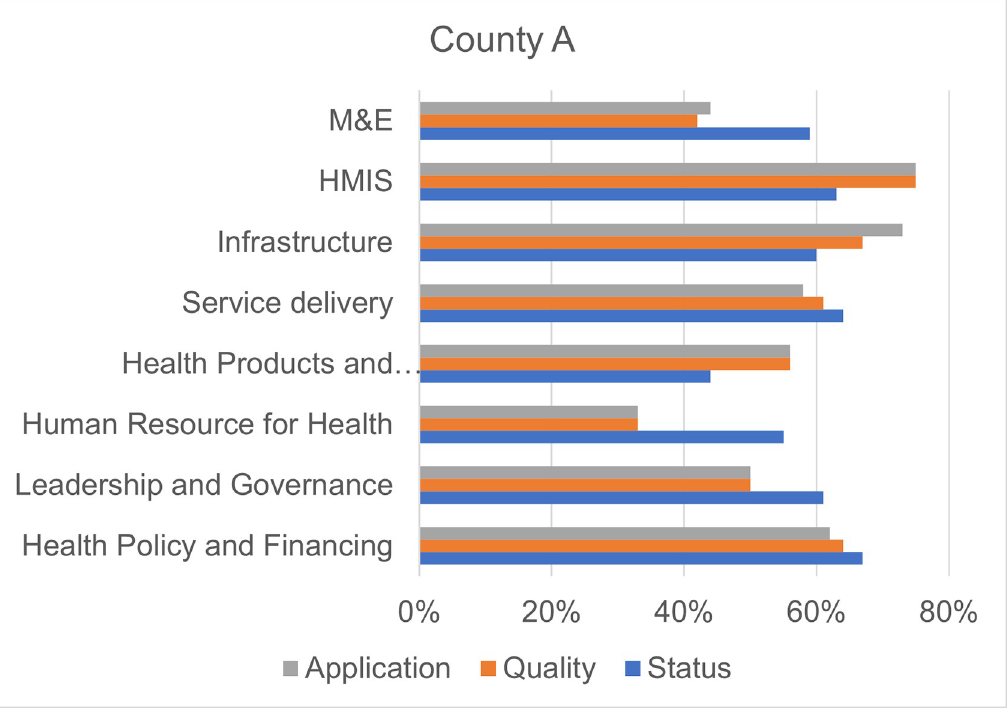
Fig 1. Scores by dimension of assessment, County